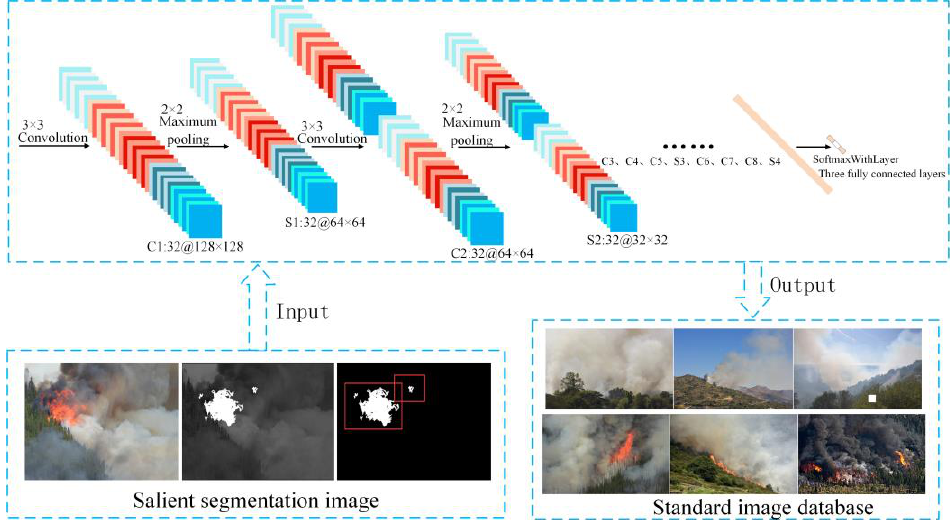
Figure 1. The architecture of the DCN_Fire